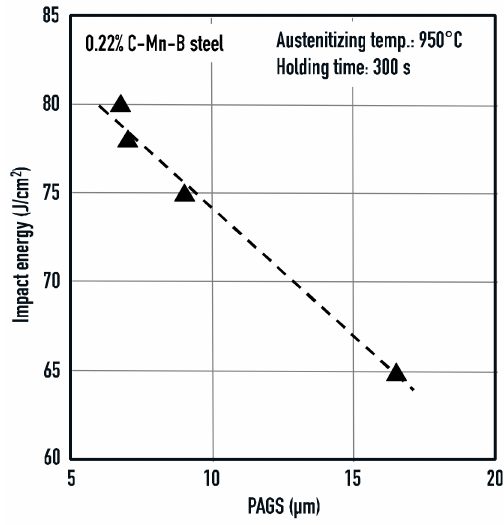
Figure 13. Effect of parent austenite grain size on upper-shelf energy for re-austenitized quenched 22MnB5 steel tested at ambient temperature (20 ◦ C).